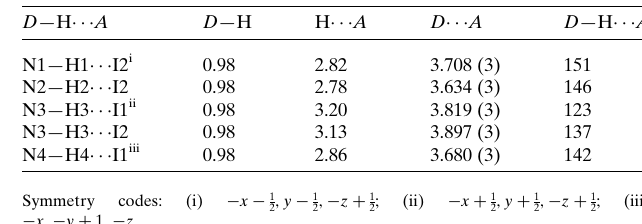
Table 2 Hydrogen-bond geometry (A˚ , (cid:5) ) for I .